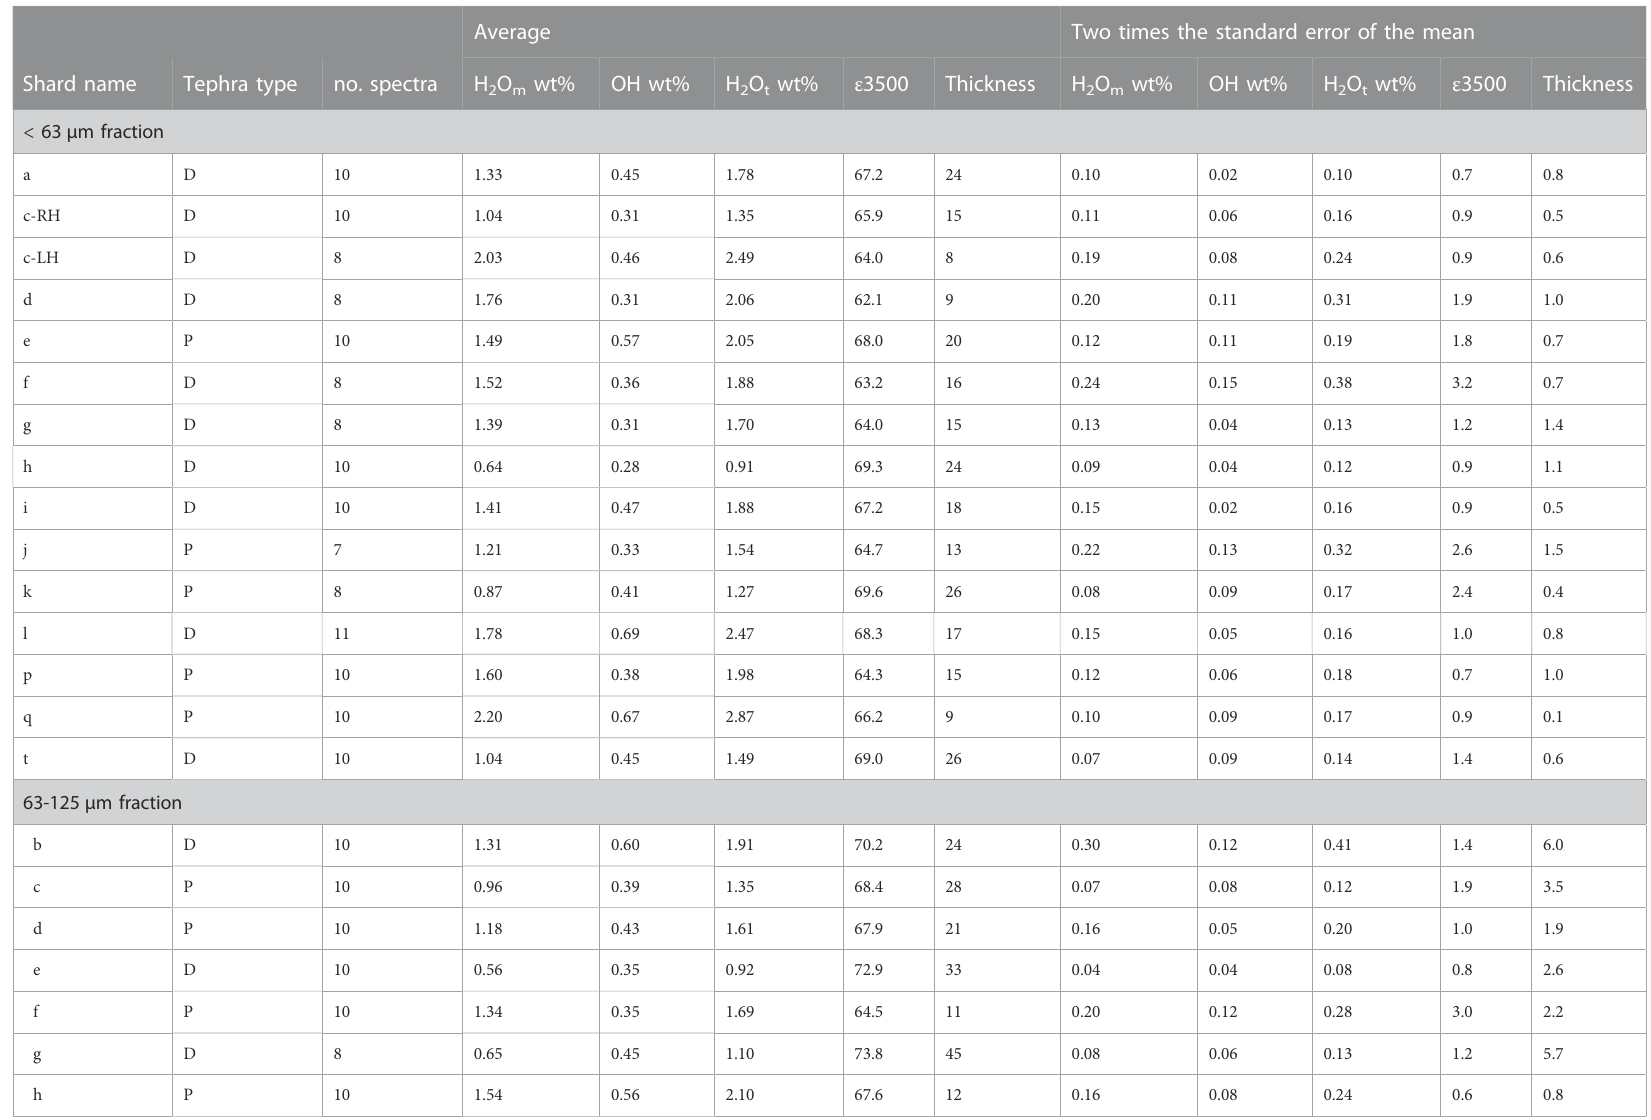
TABLE1FTIR datafor Od-1 tephra according to size fraction. Tephra type shownas D (dense/blocky) andP(pumiceous). ε 3500isthe value ofthe species-dependentmolarabsorptivity coef fi cientfor the 3,500 cm − 1